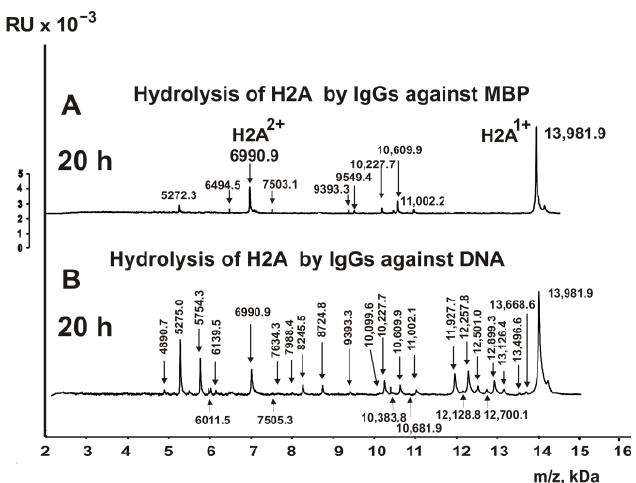
Figure 7. MALDI spectra demonstrate in time hydrolysis of H2A by IgGs (0.04 mg/mL) against MBP ( A ) and DNA ( B ).